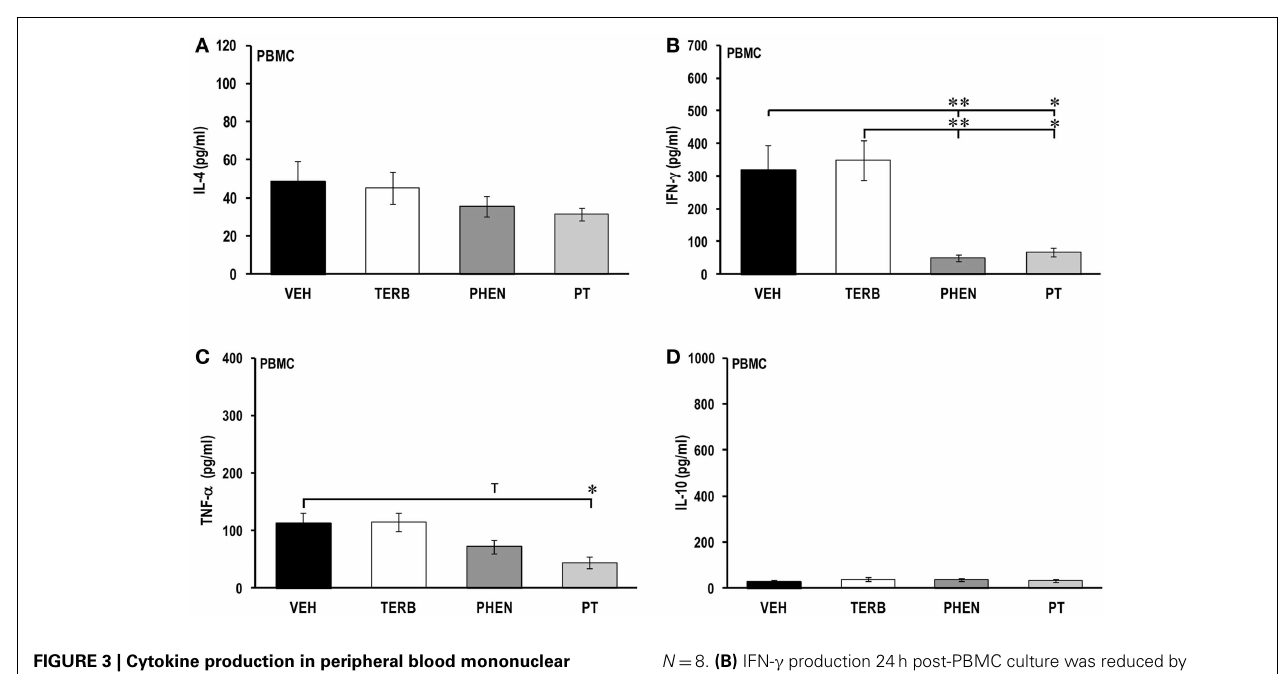
FIGURE 3 | Cytokine production in peripheral blood mononuclear cells (PBMC) . Animals were treated with twice-daily i.p. injections of vehicle (VEH, black bars), terbutaline (TERB, white bars), phentolamine (PHEN, dark gray bars), or phentolamine and terbutaline (PT, light gray bars) initiated 12days after adjuvant challenge. (A) IL-4 concentrations 24h after PBMC culture did not differ among the treatment groups.